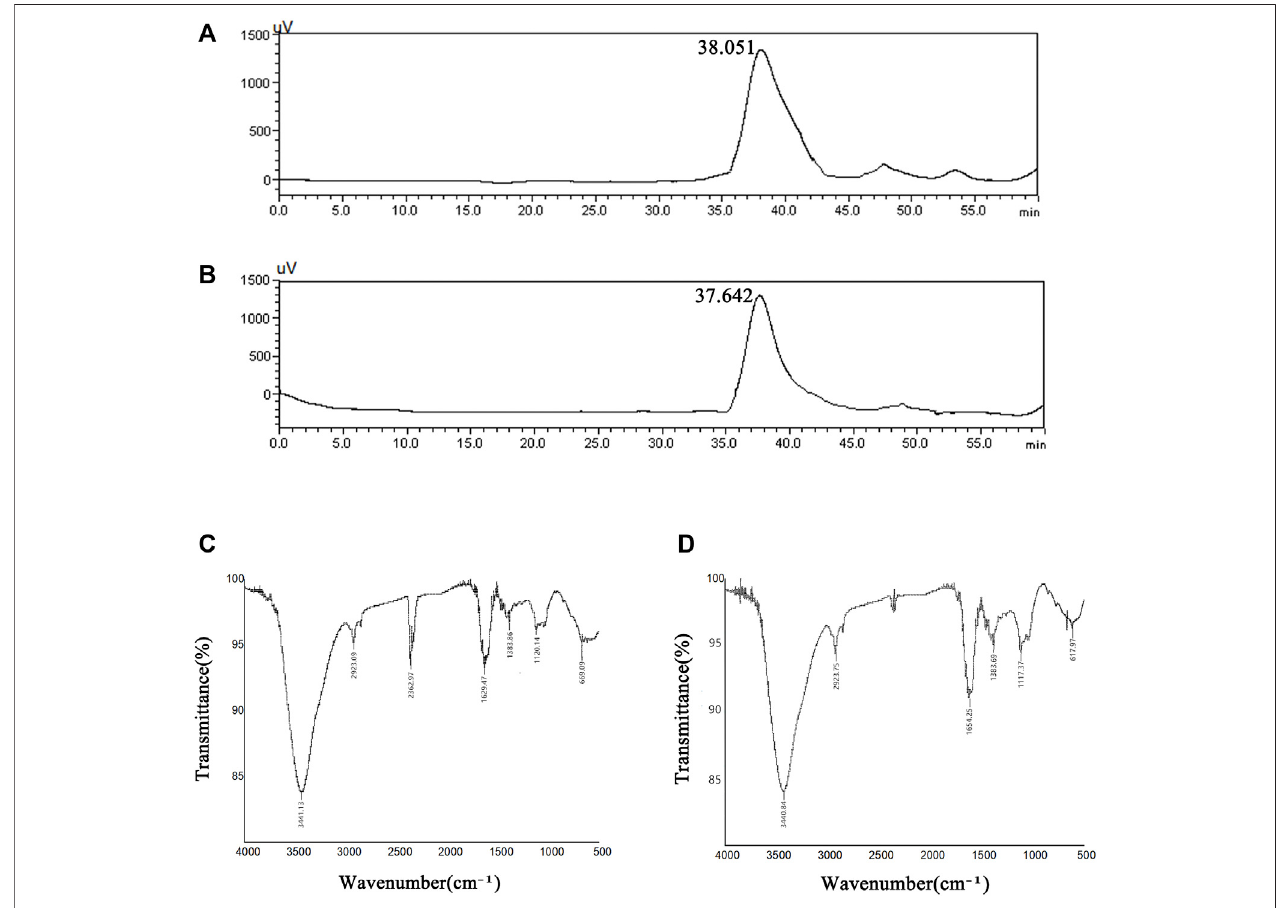
FIGURE 5 | HPLC pro fi les of SBP-1A (A) and SBP-2A (B) . FT-IR spectra of SBP-1A (C) and SBP-2A (D) .